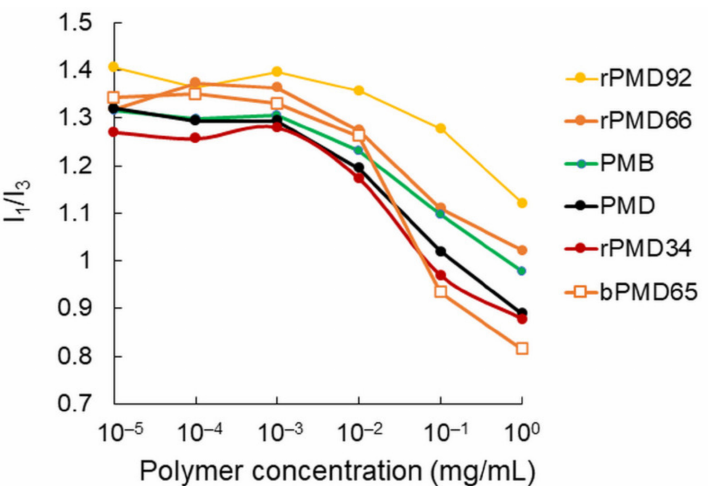
Figure 3. Hydrophobicity estimated using pyrene. The I 1 /I 3 values in pyrene fluorescence spectra were plotted against the MPC polymer